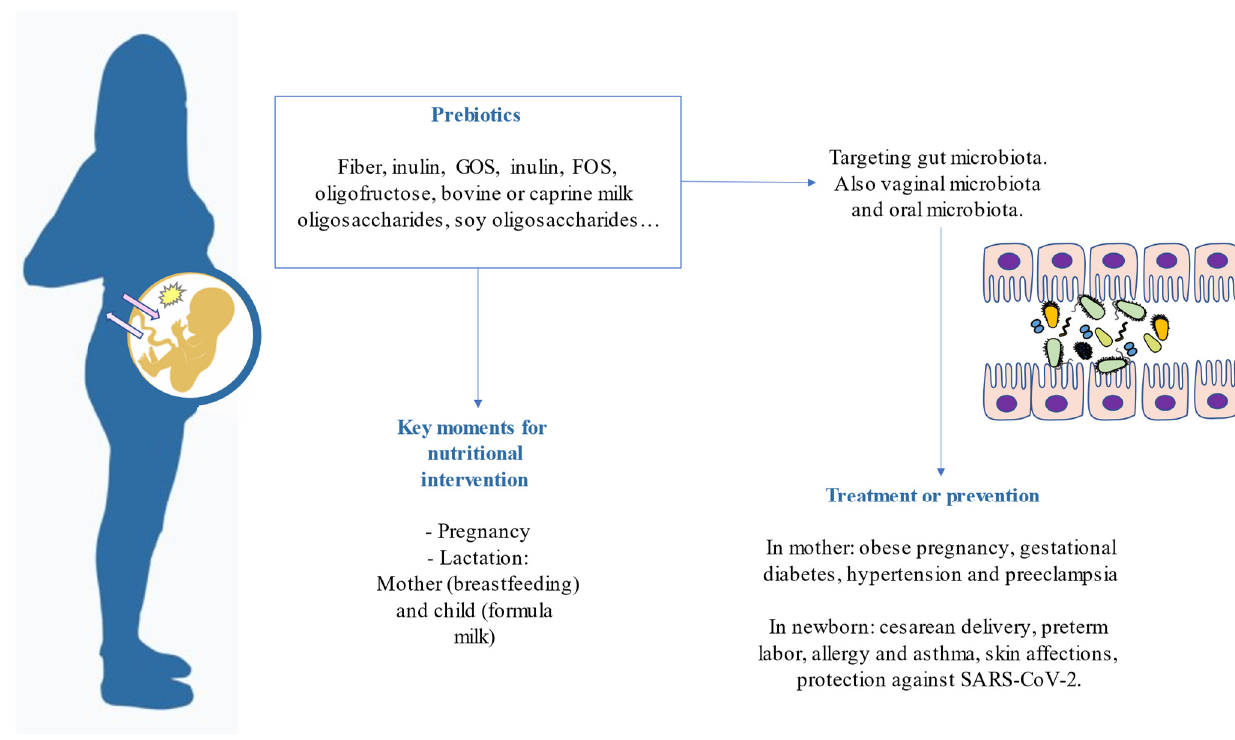
Figure 3. Highlights reviewed related to prebiotics in pregnancy and after birth.